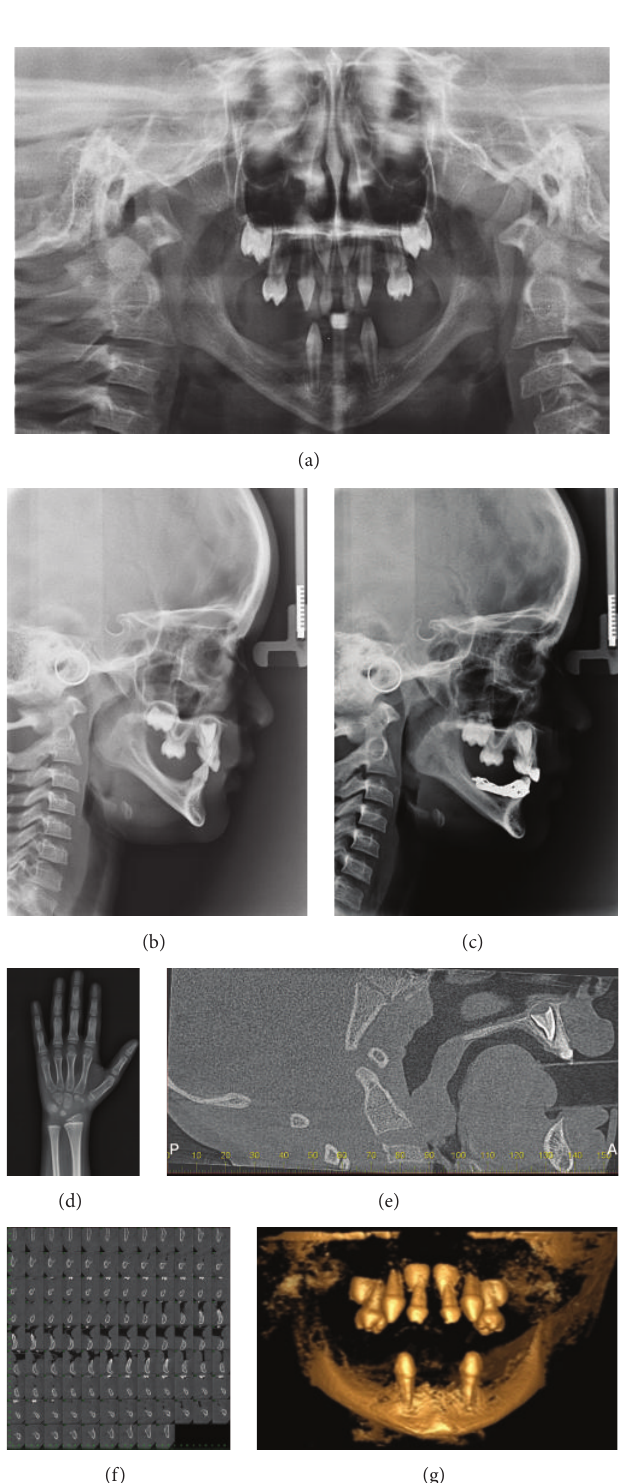
Figure 2: (a) Panoramic radiograph. (b) Lateral cephalogram showing decreased mandibular length and mandibular anterior facial height. (c) Lateral cephalogram taken 6 months after the patient began prosthetic rehabilitation. The image shows the growth pattern between the bone bases. (d) Carpal radiograph at 6 years of age matching the chronological age. (e) Computed tomography (CT) sagittal cut evidencing the presence of hypertrophic tonsils, consistent with recurrent infections of the lower respiratory tract. (f) Cross-sectional CT images showing reduced height and thickness of the alveolar bone, as well as mandibular micrognathia. (g) 3D